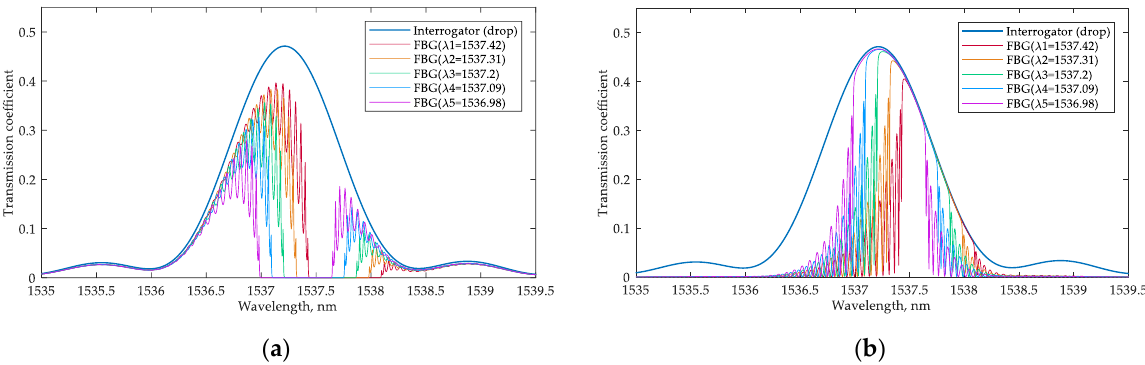
Figure 15. The combined transmission spectra at the interrogator drop port depending on the Bragg wavelength of the FBG: ( a ) for the scheme that analyzes the transmitted light; ( b ) for the scheme that analyzes the reflected light.